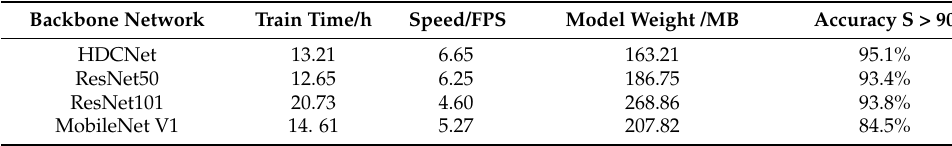
Table 4. Performance comparison of four backbone